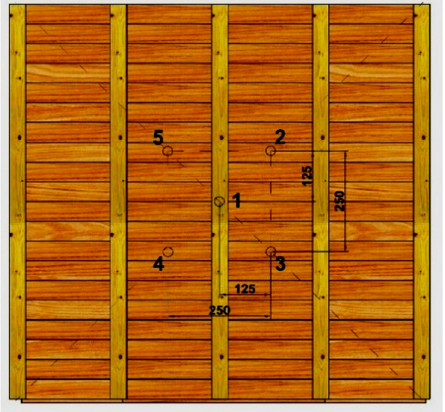
Figure 2. The five points of the basketball falling on the tested panel.